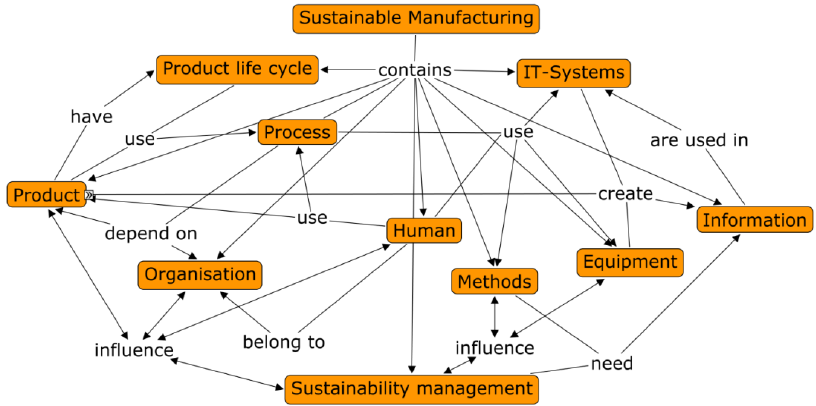
Figure 5. Overview of sub-ontologies developed.